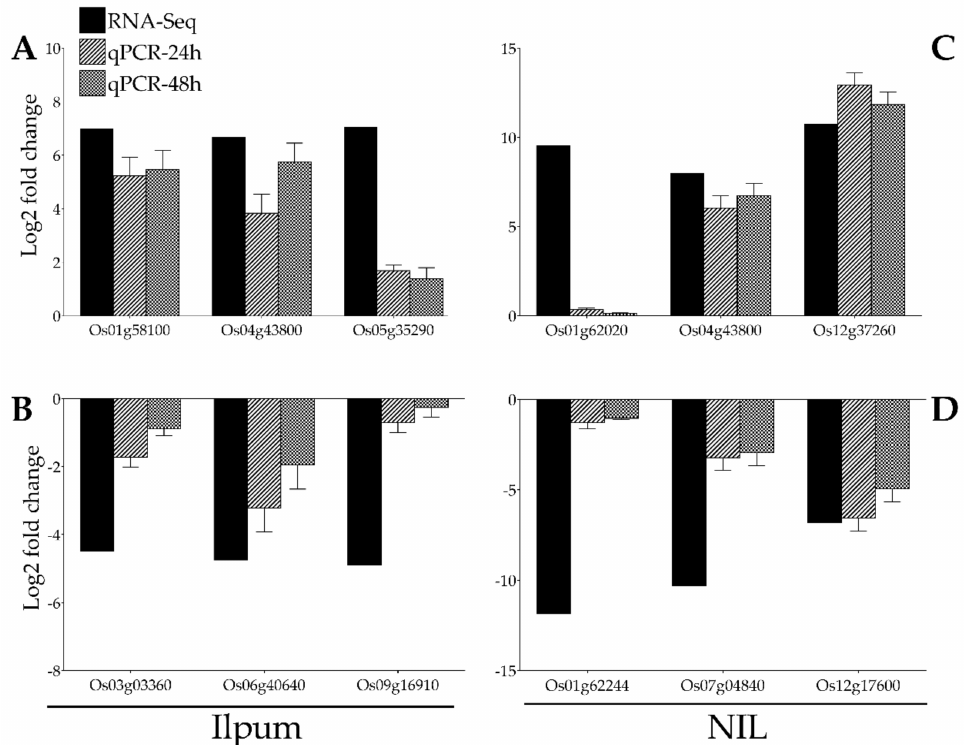
Figure 7. Confirmation of RNA-Seq results by qPCR. A total of 12 genes identified as GRH-responsive through RNA-Seq- based transcriptome analysis (black bars) in GRH-infested rice leaves from Ilpum and derived near-isogenic line (NIL) were selected to validate the fold change in their expression by qPCR (bars with motif filling). These genes belong to different functional groups involved in various metabolic pathways in rice. ( A ) Upregulated and ( B ) downregulated genes in Ilpum, and ( C ) upregulated and ( D ) downregulated genes in NIL in response to GRH